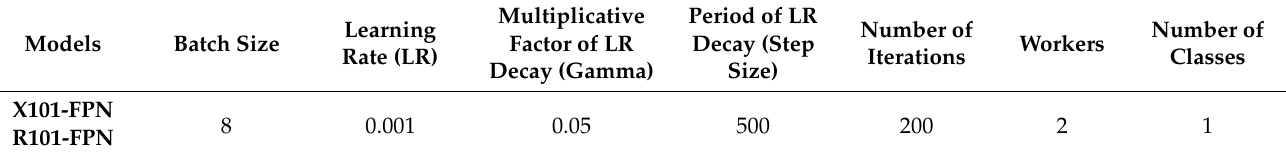
Table 1. Faster R-CNN hyper-parameters.